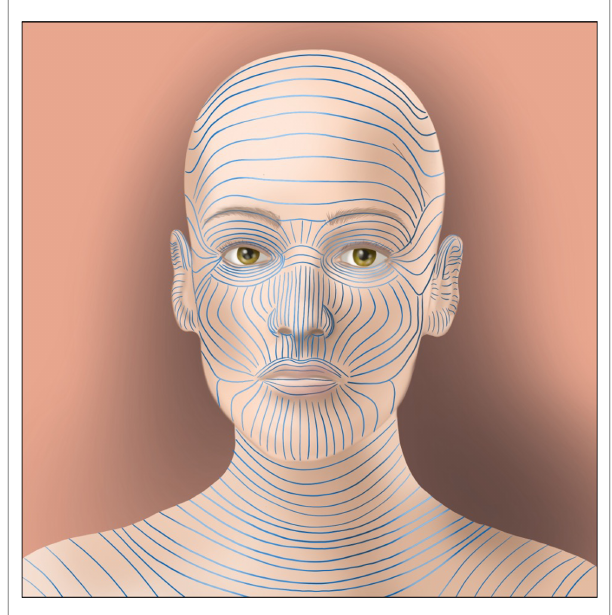
FIGURE 1 An example of Langer lines, the approximations of tension directionality across the skin surface. These lines have been recapitulated many times and are used to direct the ideal directionality of incisions to minimize tension across a wound, one of the earliest historical responses to the observation that increasing tension aggravates the scarring